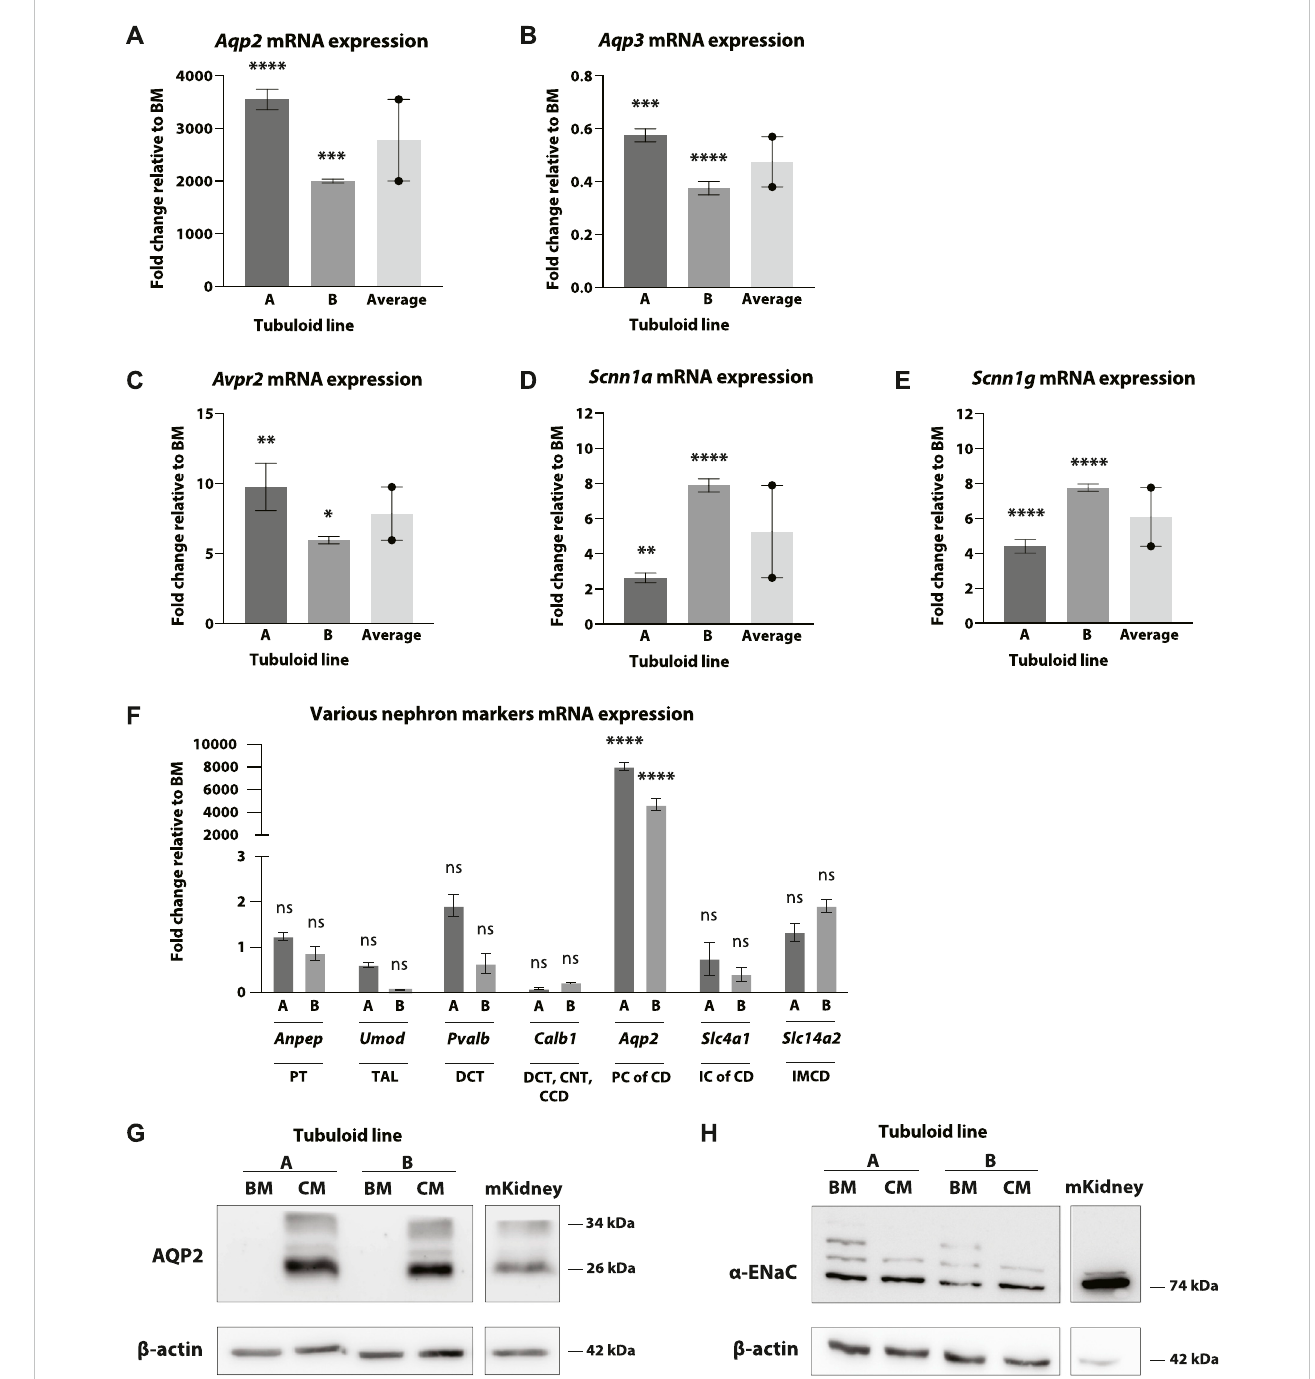
FIGURE 3 mRNA and protein expression of multiple CD transporters in CD-enriched mouse tubuloids. Fold change mRNA expression of tubuloid line A and B cultured in CD medium (CM) compared to basal medium (BM). mRNA expression of CD water transporters Aqp2 (A) and Aqp3 (B) , the V2R ( Avpr2 ) (C) and the alpha (D) andgamma (E) subunitsofENaC( Scnn1a and Scnn1g )in2tubuloidlines,(A,B),aftercultureinCM( N =2-3replicates).Averageofthe2tubuloidlines is included in all graphs ( N = 2 duplicates). mRNA expression of Anpep (PT), Umod (TAL), Pvalb (DCT), Calb1 (DCT/CNT/CCD), Aqp2 (PC, CD), Slc4a1 (IC, CD), and Slc14a2 (IMCD) in 2 tubuloid lines, (A, B), after CM culture ( N = 2/4 replicates) (F) . Western blot of AQP2 (G) and the alpha subunit of ENaC (H) in the 2 tubuloid lines after culture with CM and BM. A sample from wild type mouse kidney cortex is included as control. ns, not signi fi cant; * p < 0.05, **; p < 0.01, ***; p < 0.001, ****; p < 0.0001. CD, collecting duct; AQP2/3, aquaporin 2/3; V2R, AVP receptor; ENaC, epithelial sodium channel; PT, proximal tubule; TAL, thick ascending limb of the loop of Henle; DCT, distal convoluted tubule; CNT, connecting tubule; CCD, cortical collecting duct; PC, principal cell; CD, collecting duct; IC, intercalating cell; IMCD, inner medullary collecting duct; CM, CD medium; BM, basal